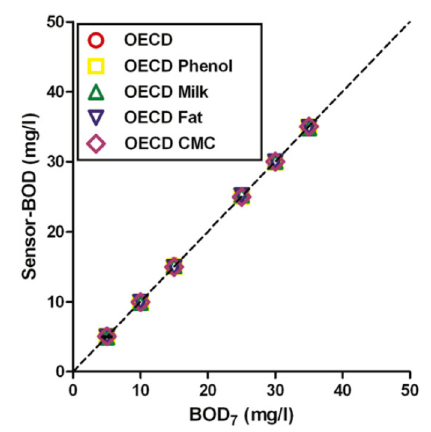
Figure 4. Measured vs. predicted plots for PLS models relating the response of biosensor array based on di ff erent semi-specific and universal microorganisms for the evaluation of biochemical oxygen demand (BOD) measurements in various synthetic industrial wastewaters. Reproduced from [11] with permission from Elsevier.